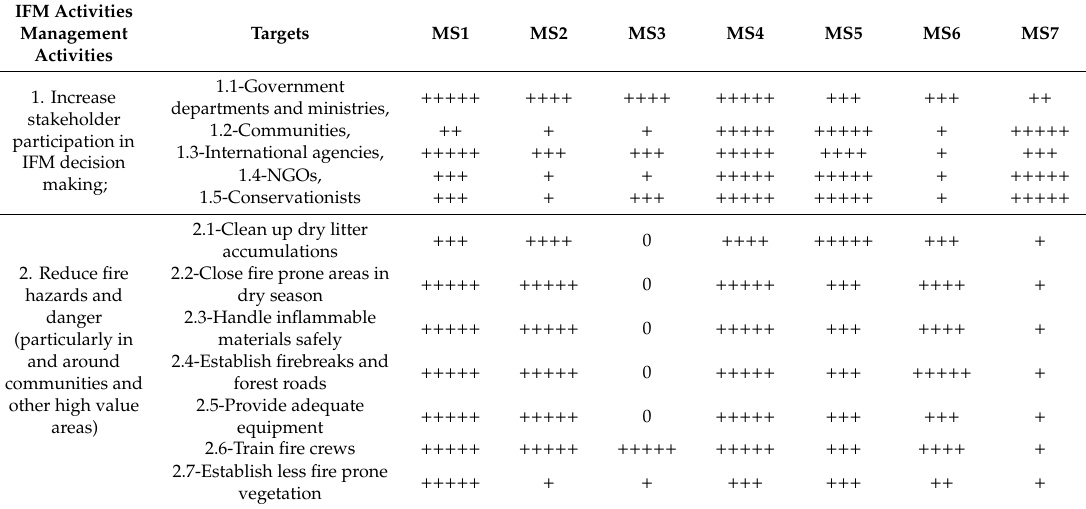
Table 1. Evaluation of the seven management strategies and their Integrated Fire Management (IFM) activities qualitatively with regard to objectives and